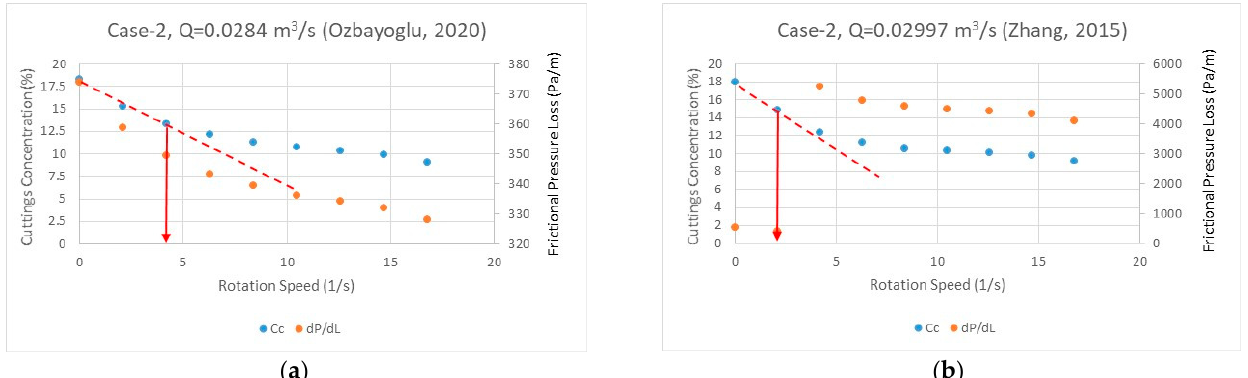
Figure 8. Determination of the optimal pipe rotation speed after the optimal flow rate is determined for Case 2: ( a ) Ozbayoglu’s model and ( b ) Zhang’s model.